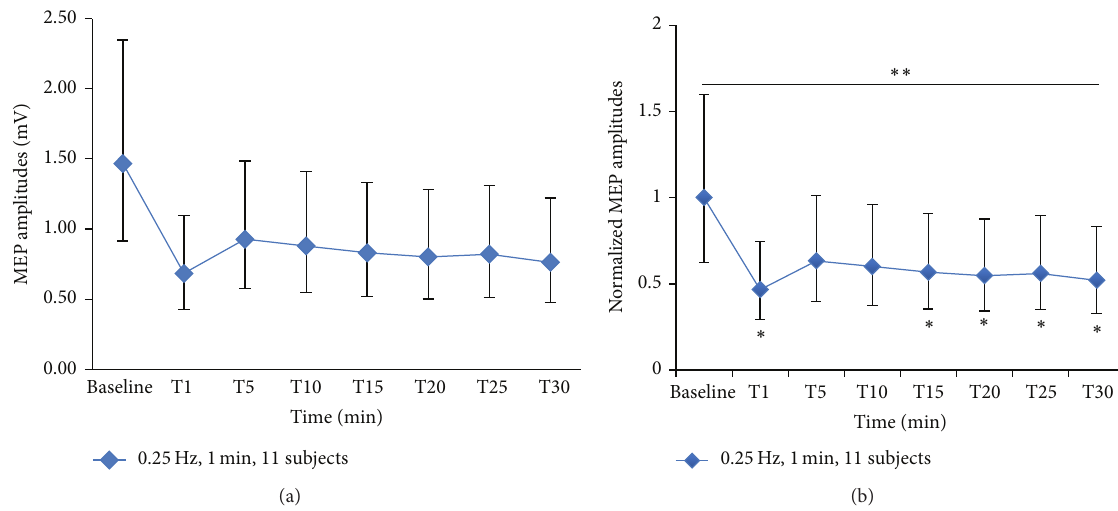
Figure 3: Original MEP amplitude and normalized MEP amplitudes of 11 subjects with 95% confidence interval of 1-minute stimulation of 0.25 Hz PAS 10 ms . The original MEP amplitudes are reported as a median with 95% confidence interval (a). One-way repeated-measures ANOVA showed a significant LTD-like effect in 11 subjects (reported as an uncorrected 𝑝 value) ( ∗∗ 𝑝 value < 0.05). Post hoc analysis showed that the inhibitory effect began immediately after applied PAS 10 ms (T1), 15 (T15), 20 (T20), 25 (T25), and 30 minutes (T30) ( ∗ 𝑝 value < 0.05). The maximum inhibition was approximately 55% reduction (b). Min = minute, MEP = motor-evoked potentials, LTD = long-term depression, and PAS 10 ms = paired associative stimulation with interstimulus interval of 10